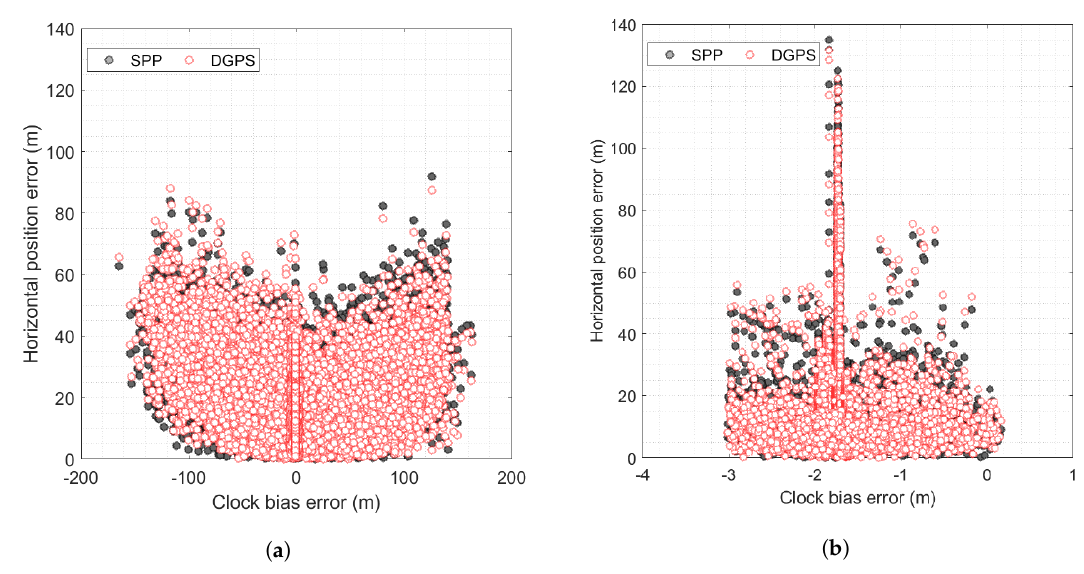
Figure 6. Horizontal error versus clock bias error. Grey markers represent data for the Single-Point solution, while red circles represent data for the Code Differential positioning (DGPS) technique: ( a ) Steering on; ( b ) steering off.